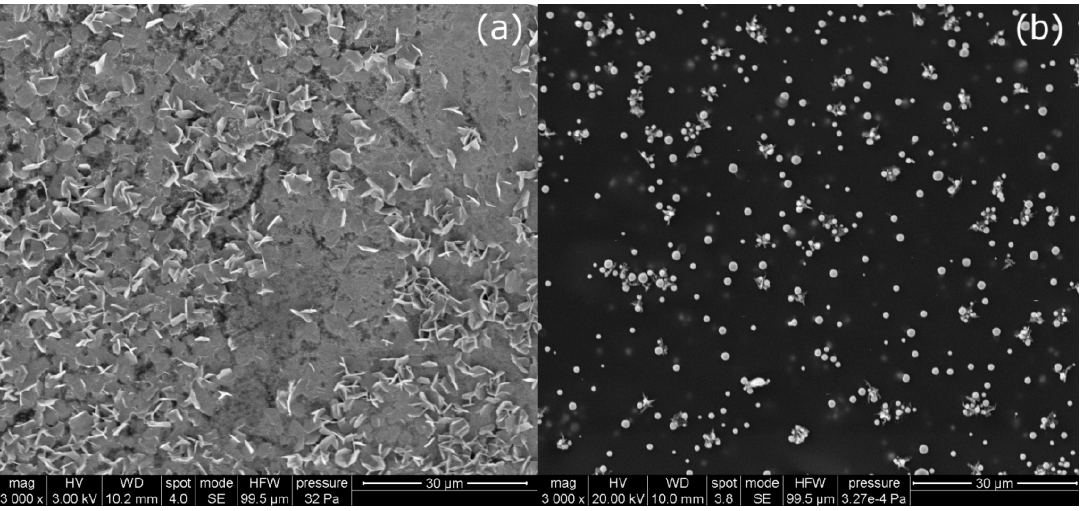
Figure 3. SEM images of Zn/AC-850 ( a ) and Cu/AC-850 ( b ).